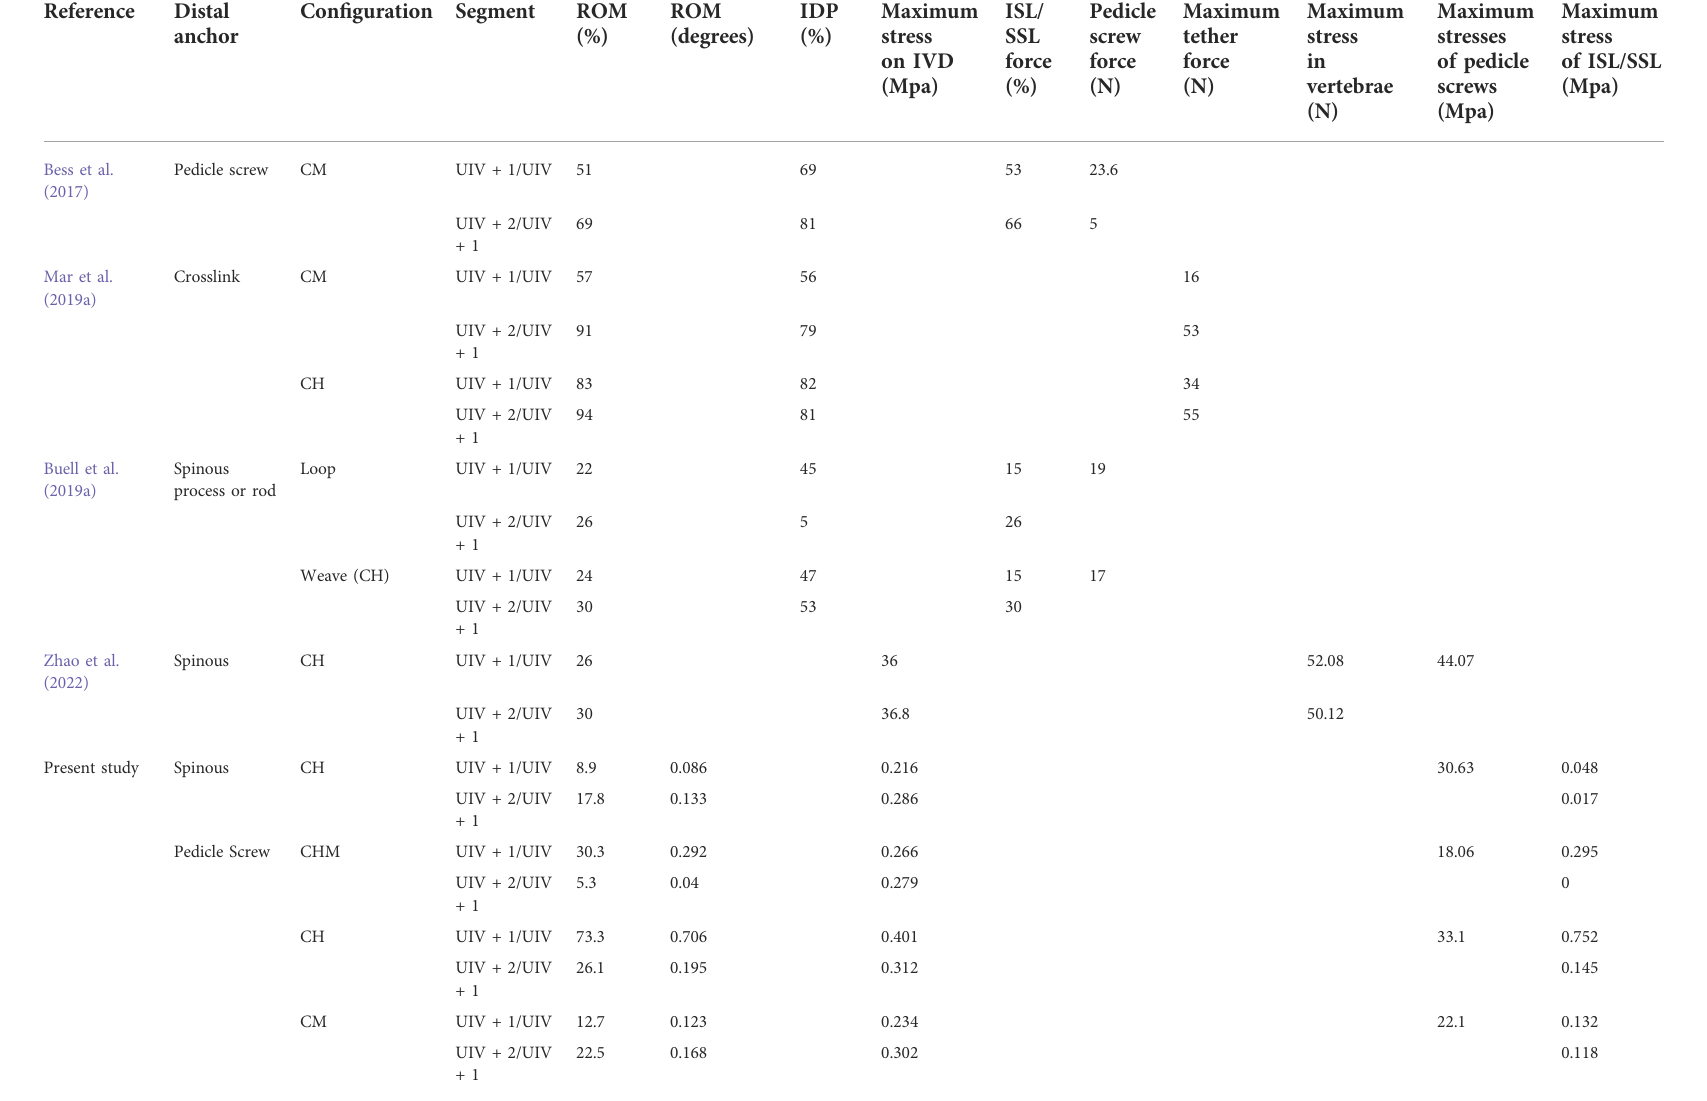
TABLE 2 List of biomechanical research tests for ligament augments in UIV + 2/UIV + 1 and UIV + 1/UIV segments compared with distal anchor, con fi guration, and parameters.